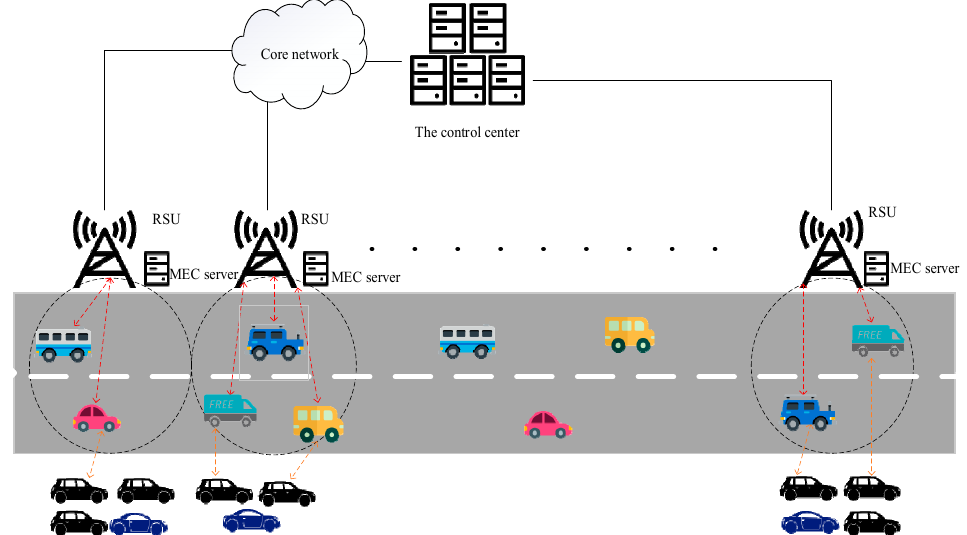
Figure 1. Collaborative mobile edge computing task offloading model for roadside Figure 1. collaborative mobile edge computing task offloading model for roadside parking.